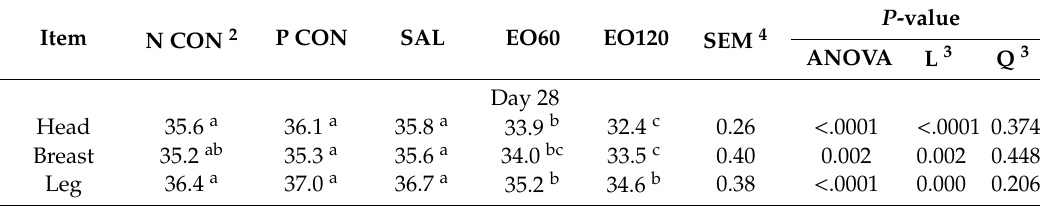
E ff ect of dietary encapsulated essential oils on body surface temperature ( ◦ C) in coccidiosis-vaccine-challenged broiler chickens